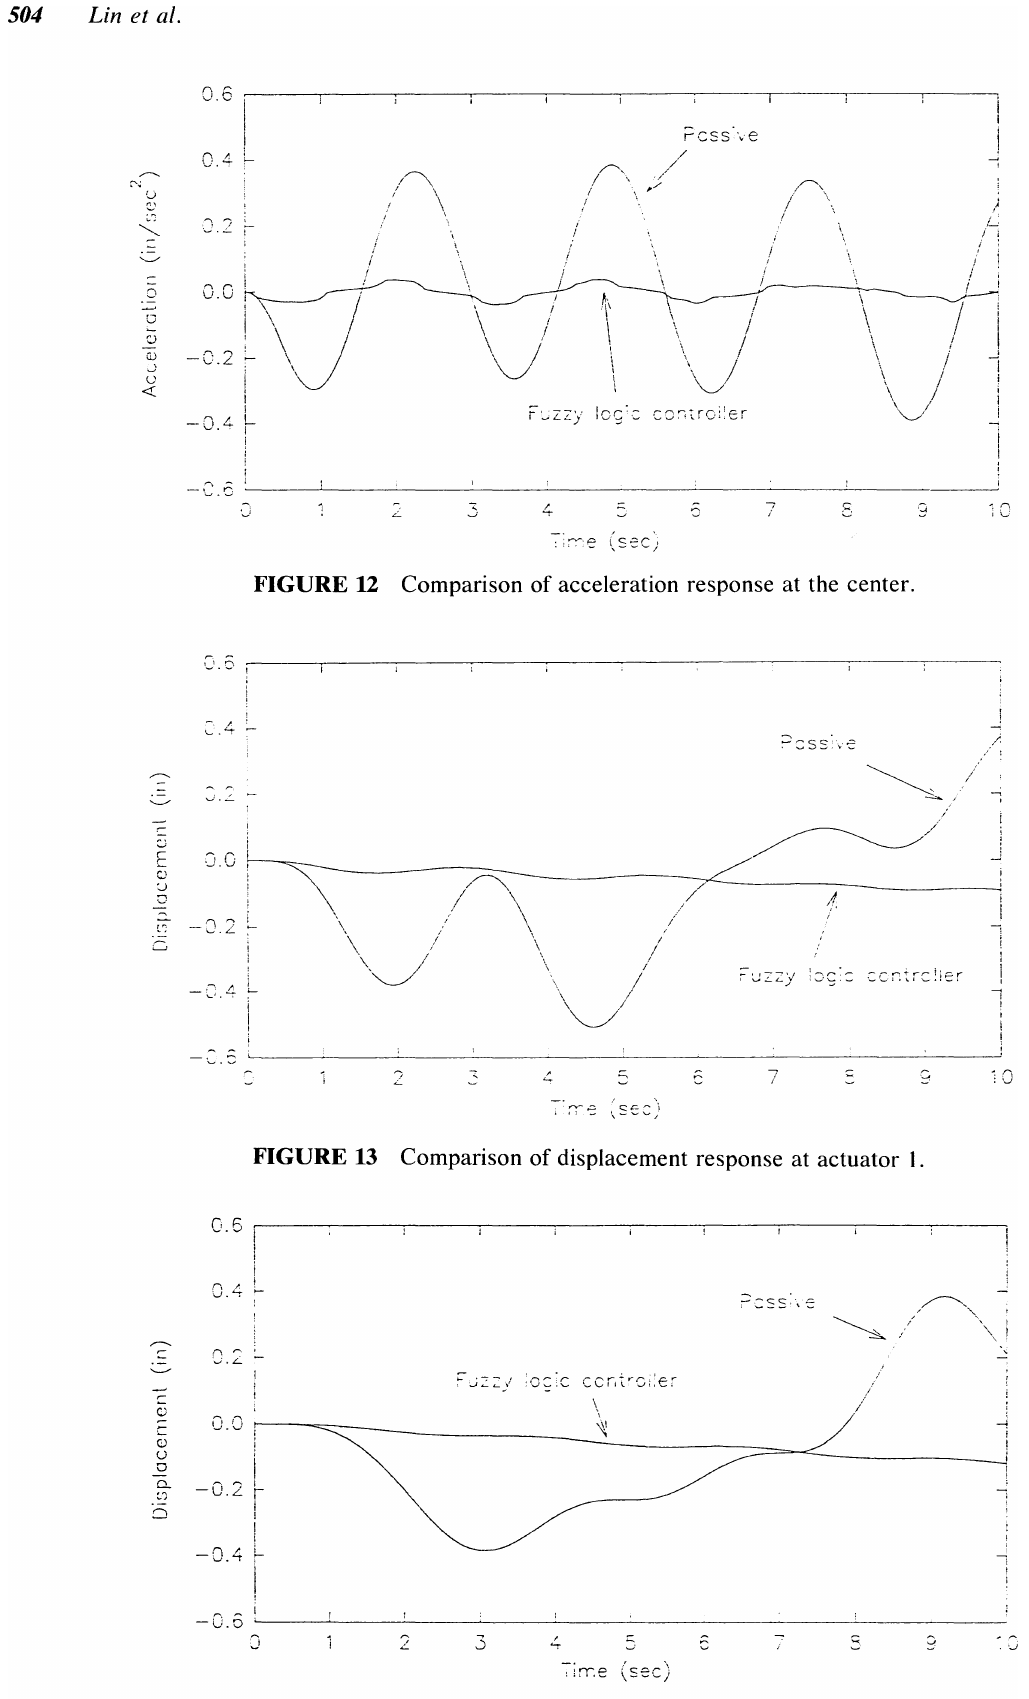
FIGURE 14 Comparison of displacement response at actuator